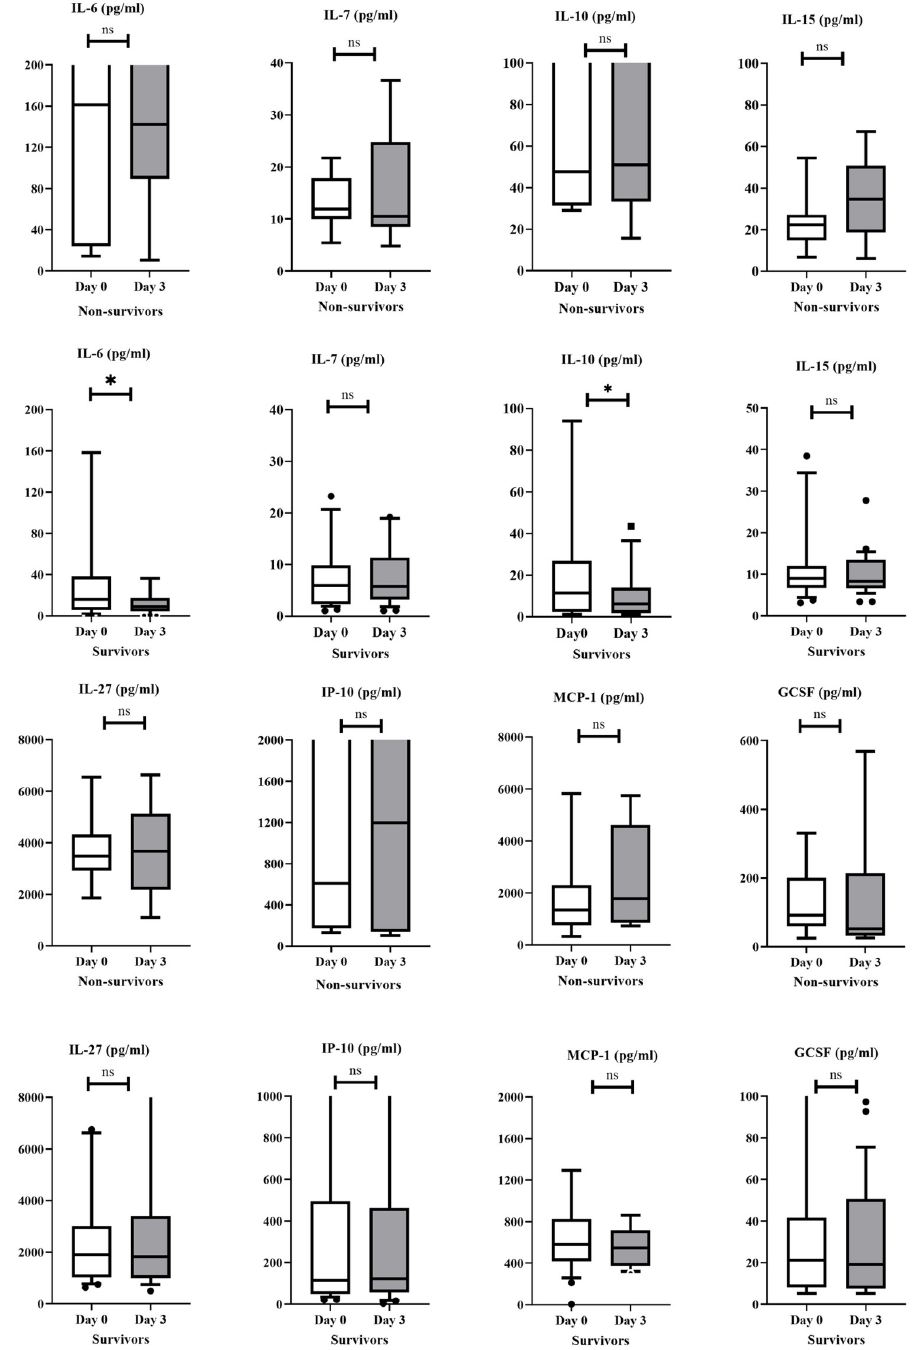
Fig 1. Evaluation of changes in some cytokine levels in survivor and non-survivor